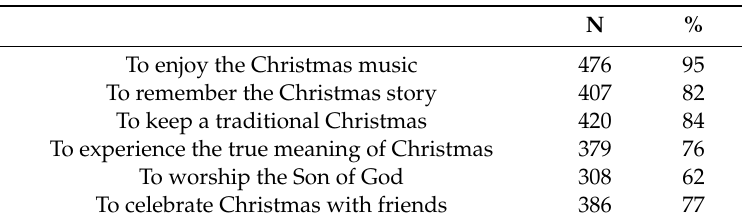
Table 12. Motivation for